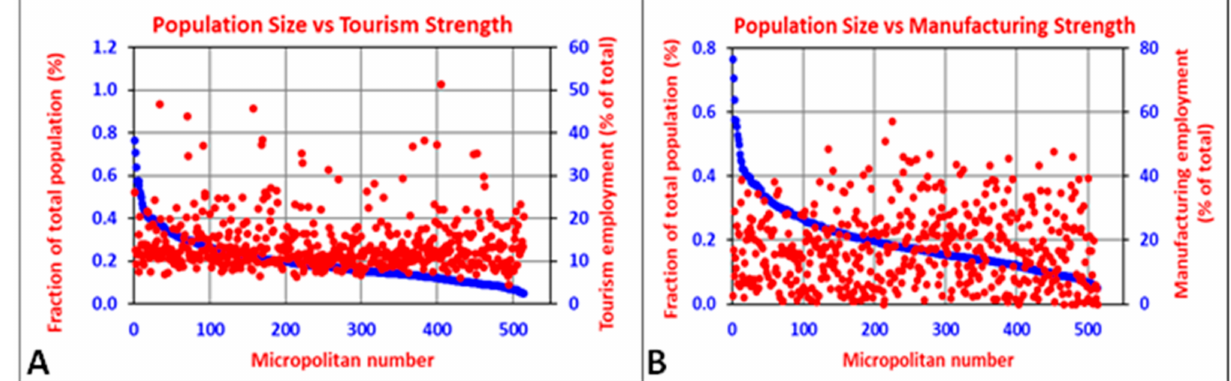
Figure 3. Comparison of ranked population strengths (percentage of total micropolitan population, blue dots) of micropoli- tans with ( A ) the strength of their tourism employment (percentage of total tourism employment, red dots) and ( B ) the strength of their manufacturing employment (percentage of total manufacturing employment, red